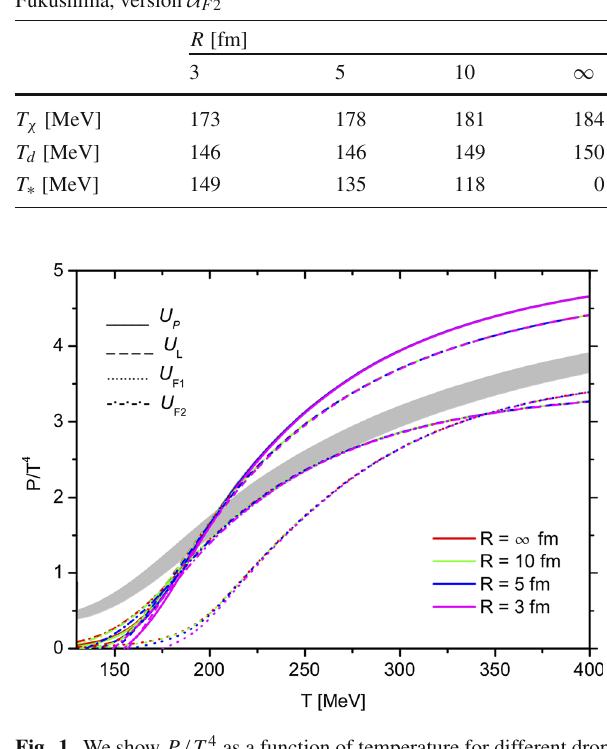
Fig. 1 We show P / T 4 as a function of temperature for different drop sizes and different Polyakov loop potentials. The gray band are the results for the equation of state in (2+1)-flavor QCD using the highly improved staggered quark action extrapolated to the continuum limit [48] (see also [49])